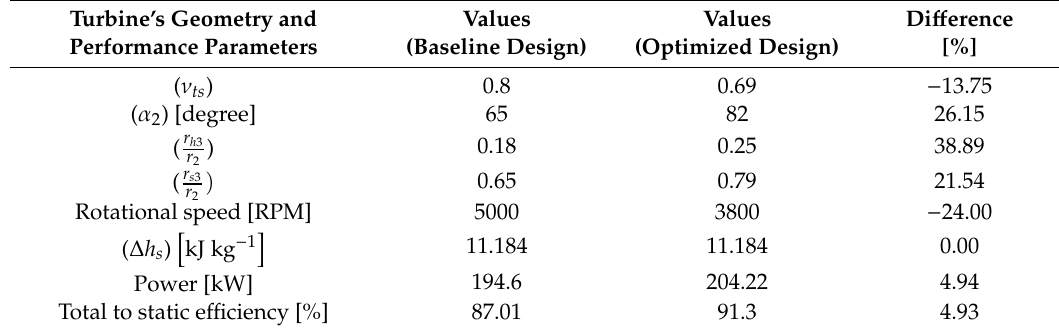
Table 4. Comparison of results for the meanline design and optimized design.